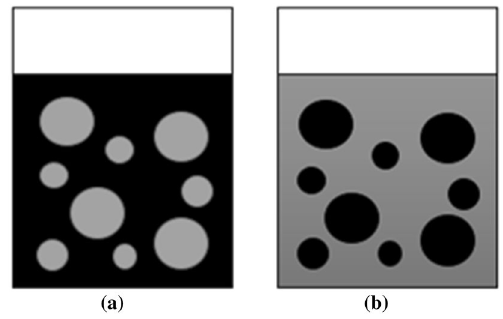
Fig. 5 A schematic illustration of water-in-oil ( a ) and oil-in-water emulsions ( b